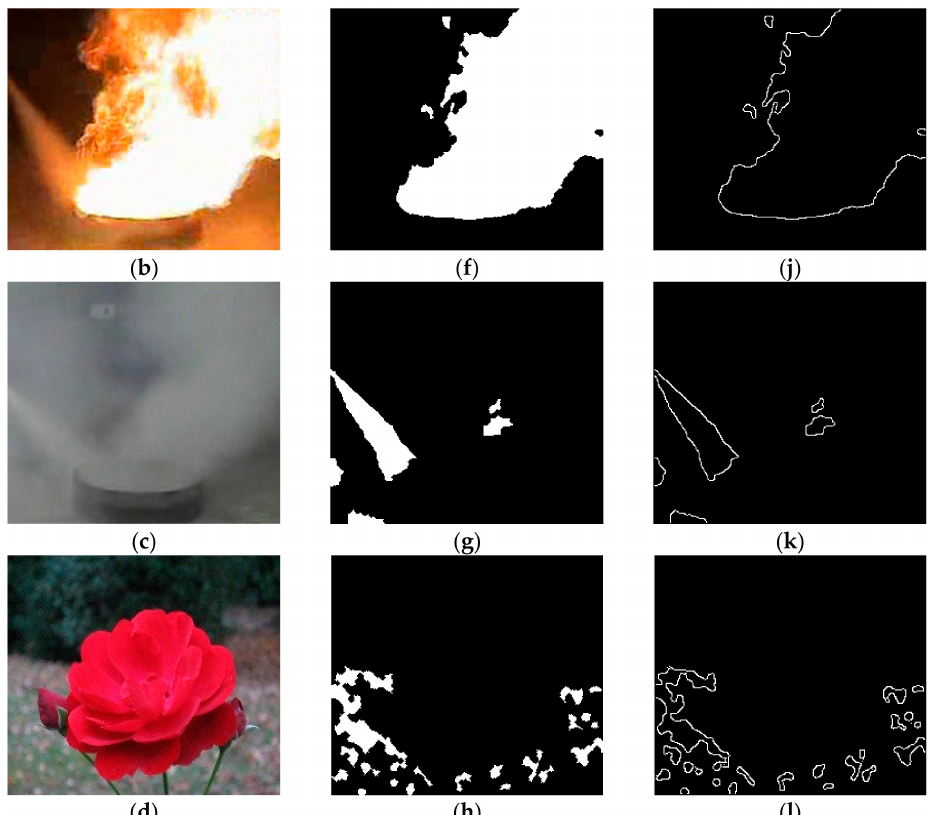
Figure 4. Results of pre-processing: ( a – d ) original images; ( e – h ) pre-processed images; ( i – l ) edge